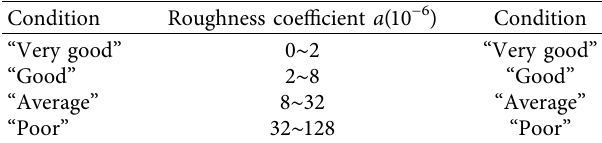
Table 7: Roughness coefficient for different surface conditions.